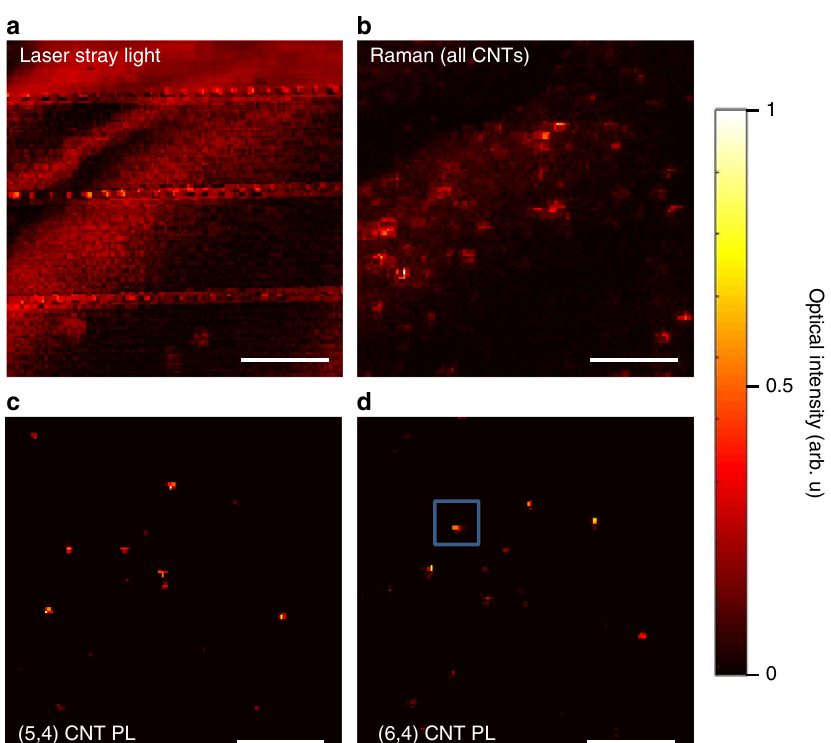
Fig. 2 Hyperspectral imaging of SWCNT distribution. a Laser stray light scanning off of sample surface revealing structural features similar to Fig. 1c and also signatures of deposited material. b Hyperspectral Raman imaging of same sample surface area, capturing the G-mode phonon of all SWCNTs. c Hyperspectral PL map of same area revealing (5, 4) SWCNTs fi ltered at 855 ± 10 nm. d Hyperspectral PL map of same area revealing (6, 4) SWCNTs fi ltered at 880 ± 10 nm. Data are recorded at a sample temperature of 3.8 K. Scale bars are 10 μ